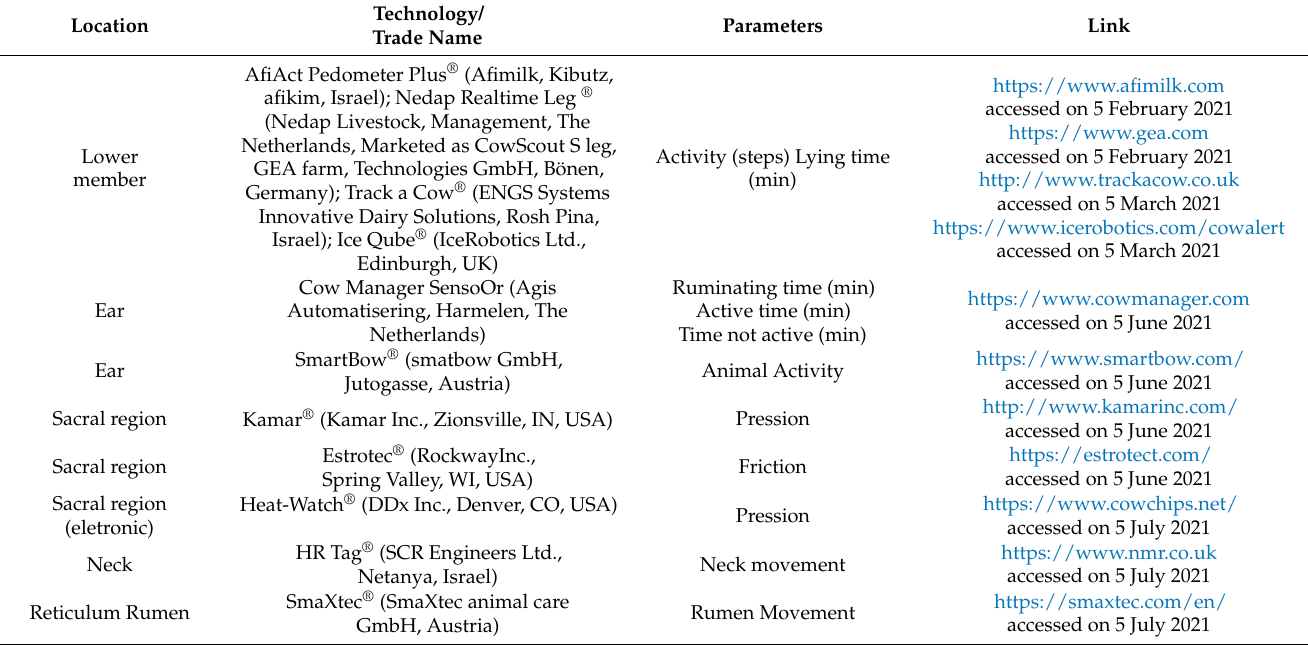
Table 1. Commercially available estrus detection